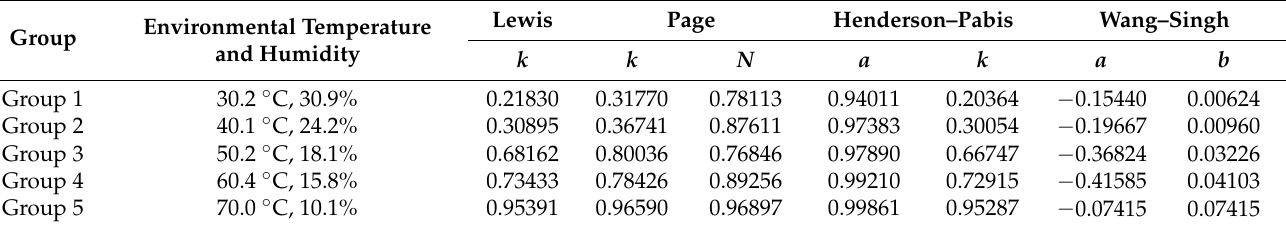
Table 5. Calculation parameters of the drying kinetic model.